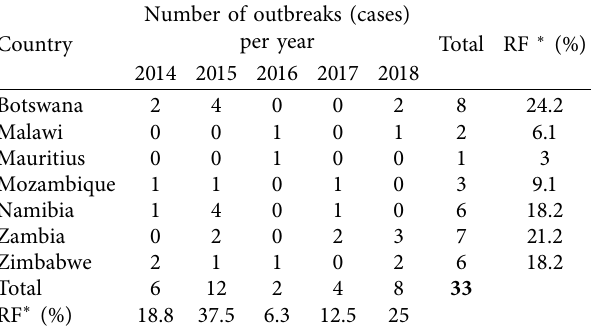
Table 1: Distribution of foot-and-mouth disease outbreaks in cattle by country in some southern African countries,